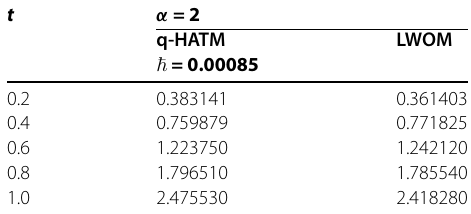
Table 2 Comparison of LWOM with q-HATM [22] at σ = 0.1, x = 1, and n = 3